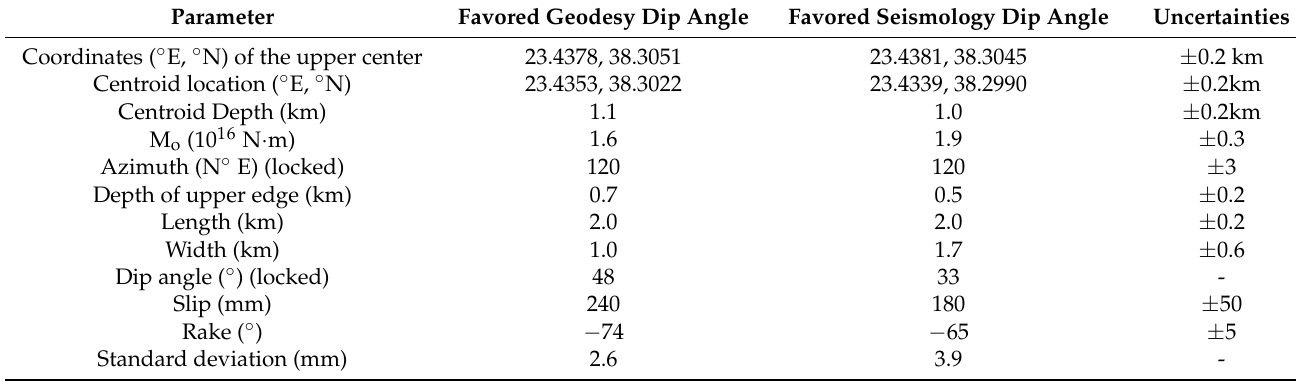
Table 1. Parameters of the two geodetic models, for the dip angle favoring geodesy and for the dip angle favoring seismology (bold line). The standard deviation of the measured and modeled deformation values (plotting in Figure 4) are mentioned. The uncertainties of the parameters are also included. Parameter Favored Geodesy Dip Angle Favored Seismology Dip Angle Uncertainties Coordinates ( ◦ E, ◦ N) of the upper